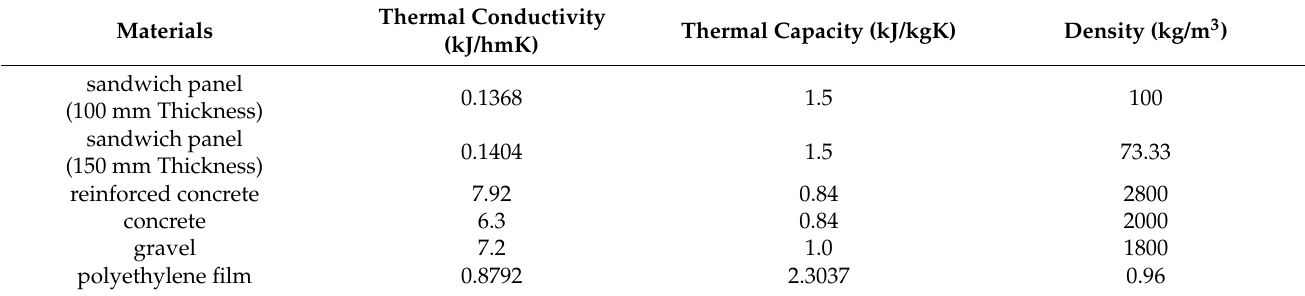
Table 1. Physical properties input to the broiler house structural